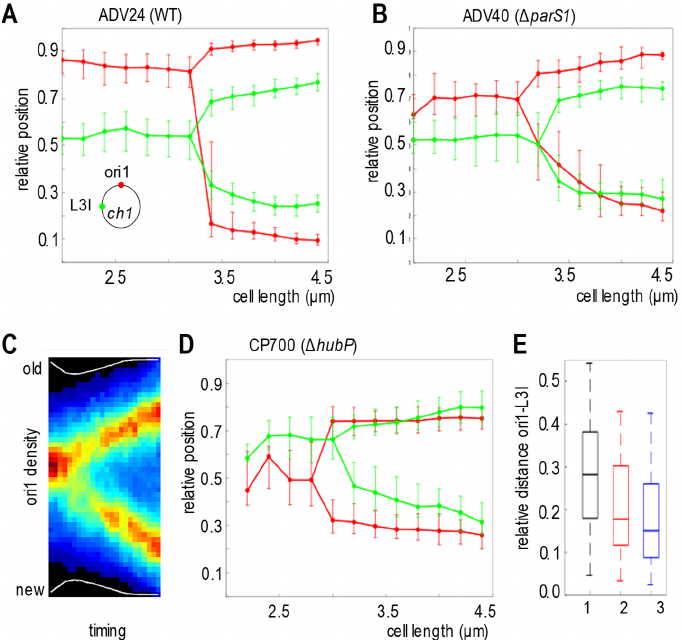
Figure 3. Mid-cell positioning of ori1 in Δ hubP cells. ( A , B , D ) Reconstituted choreographies of ori1 and L3I foci in ADV24 (WT) (A), ADV40 ( ∆ 3 parS1 ) (B) and CP700 ( ∆ hubP ) (D) from snapshots anal- ysis. In ( A , B ), pole 1 is determined using the most polar ori1 focus as a reference (Ref [6] and Figure S6). In ( D ) pole 1 is determined using the most polar L3I focus as a reference (Figure S7). The median, the 25th and the 75th percentiles of the relative cell position of each locus are plotted for each cell size interval of 0.2 µm. ( C ) Average positioning of ori1 obtained from the compilation of 56 lineages of Δ hubP ori1 -tagged cells videotracked over an entire cell cycle. In the heat map, black corresponds to the lowest and dark red to the highest ori1 fluorescence intensities. y axis: position along the cell length, with 0 corresponding to the new pole and 1 to the old pole. x axis: cell cycle, with 0 corre- sponding to birth and 1 to scission. ( E ) The relative distance between ori1 and L3I loci was measured as a function of the relative cell length in the cells containing only one focus of each locus. The